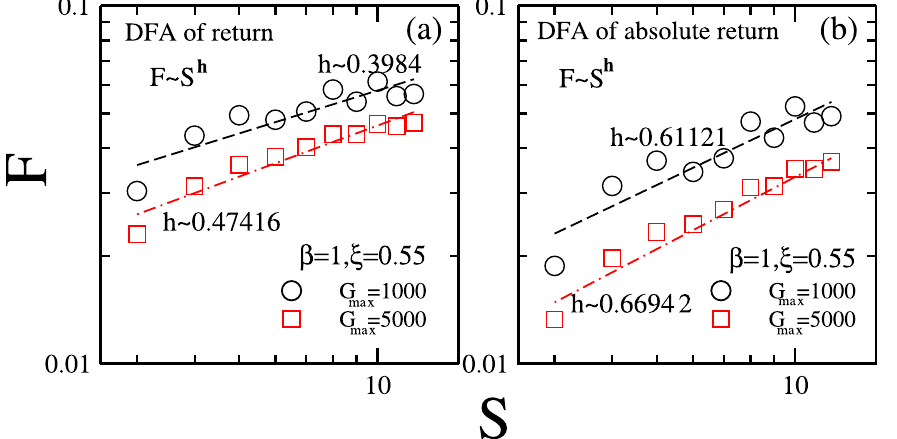
Fig 2. (a) The hurst exponent of price returns for the maximal risk tolerance of reference point strategies G = 1000 max (circles), 5000 (squares); (b) the hurst exponent of absolute price returns for G max = 1000 (circles), 5000 (squares). Other parameters are: the population size N = 5001, the memory size m = 3 and m 0 = 10, the market impact β = 1, the ratio of individuals with reference point strategies ξ = 0.55, the updating threshold of history-dependent strategies S th = 0, the maximum drift of history-dependent strategies ε = 0.1, the liquidity l ¼ N , the constant a ¼ 10 , minimum and 10 N maximum shares holding k = -1, k = 1. Final data are obtained by averaging over 50 runs and 10 4 times after 10 5 min max relaxation times in each run. The initial conditions are: an individual’s risk tolerance G is uniformly distributed within i the range of G 2 [0, G ], an individual’s initial reference point p ref is uniformly distributed within the range i max i